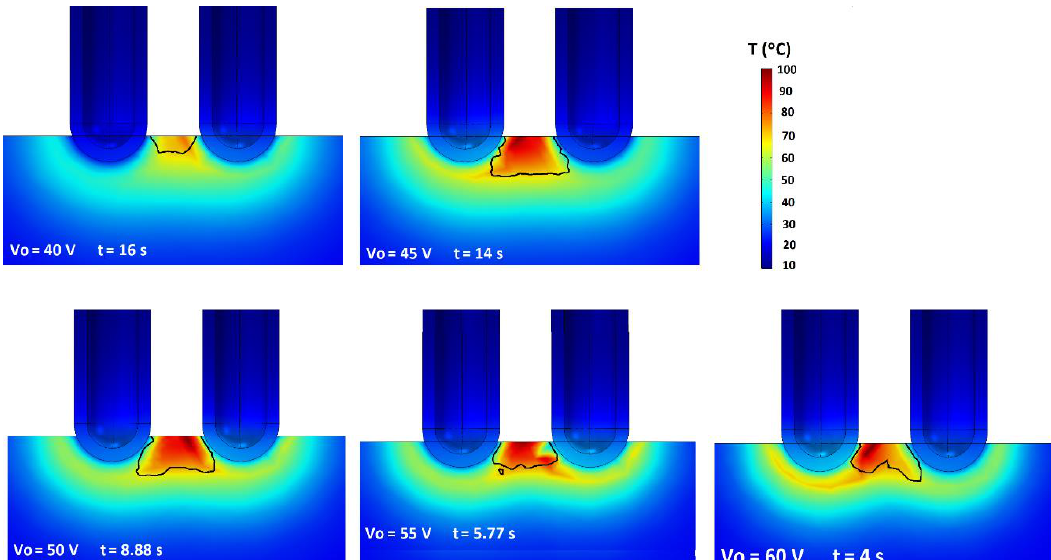
Figure 6. Temperature distribution (°C) and isosurface Ω = 1 (black line) for SMM in the symmetry plane of the geometry representing cases of V 0 = 40 (t = 16 s), 45 (t = 14 s), 50 (t = 8.88 s), 55 (t = 5.77 s), and 60 V (t = 4 s), as selected in Table 2. The times in each graph are the times that satisfied the stop criterion.